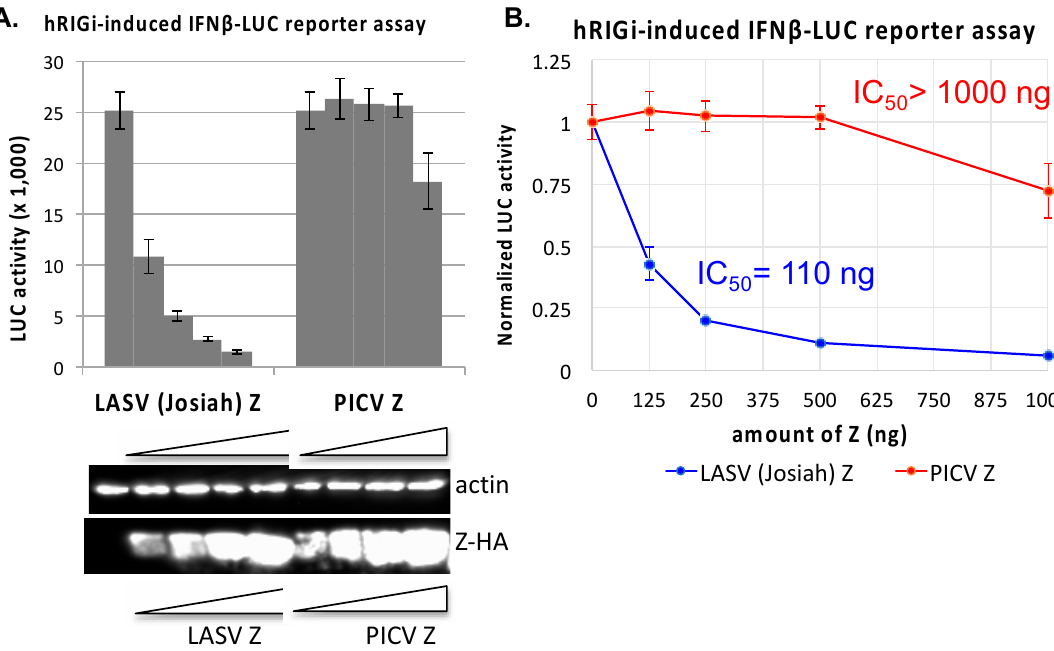
Figure 2. Comparative hRIG-I inhibitory analysis of LASV (Josiah) and PICV Z proteins. The effects of either LASV (Josiah) or PICV Z protein (in a dose-dependent manner) to inhibit the human RIG-I-N-induced IFN β promoter-driven LUC reporter gene expressions were measured. 293T cells were transfected with a combination of plasmids (pEF-RIG-I-N, IFN β -LUC reporter plasmid, and a β -Gal expression plasmid) together with either an empty vector or an increasing concentration of the Z expression plasmid. LUC reporter activity was measured at 24 h ( A ) and normalized by that in empty vector control ( B ). The expression of Z proteins in the cells was detected by a Western blot analysis using an anti-HA antibody. IC 50 value was determined by the amount of the Z plasmid required to reduce the LUC reporter activity by 50%. Each plasmid transfection experiment was conducted in triplicate and repeated in at least two independent